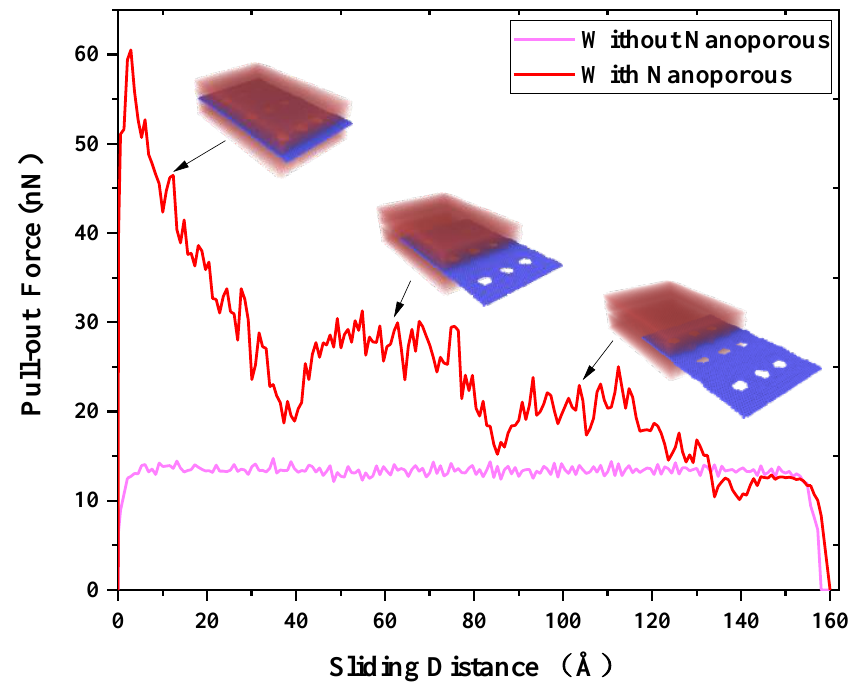
Figure 4. The pull-out force changes as a function of the sliding distance for the graphene/Cu composite with and without nanoporous.